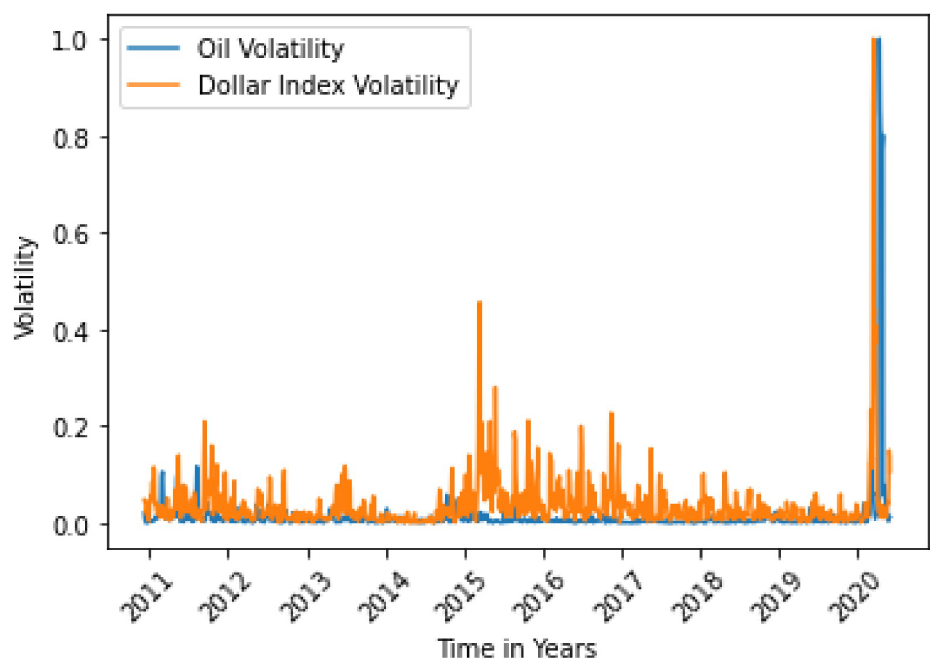
Fig 11. Dollar Index variance Granger causes oil variance after 7 days. Here, the correlation between two data is 0.0388.